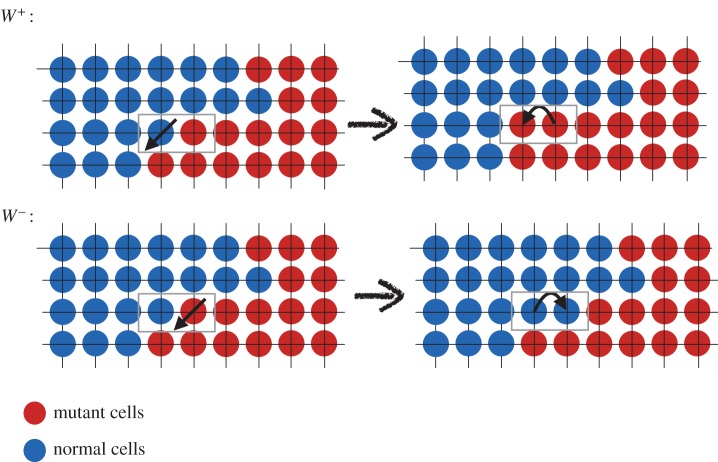
Sequence of death and birth events on the boundary of mutant clone (red) that give rise to the increase or decrease of mutant population. (Figure is depicted for a DB process.)